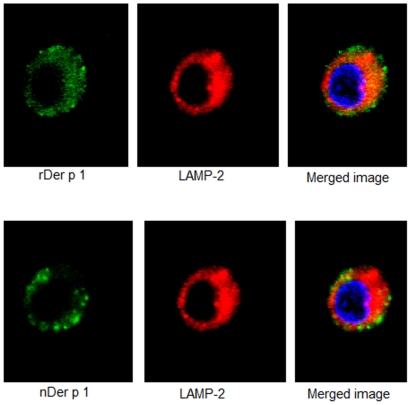
The co-localization of natural and recombinant Derp1 (0.5 µg/ml) with LAMP-2 detected at 10 mins.A. Green: rDer p 1 stained with FITC, red: LAMP-2 stained with PE, blue: nucleus stained with DAPI. B. Green: nDer p 1 stained with Cy5, red: LAMP-2 stained with PE, blue: nucleus stained with DAPI.